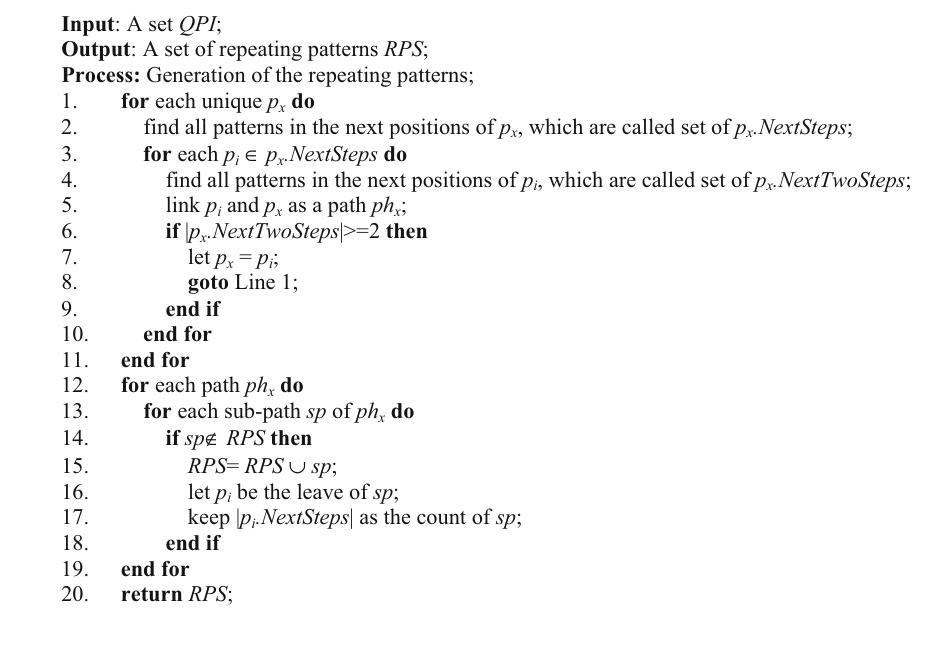
Fig. 3 Algorithm of generating of repeating patterns